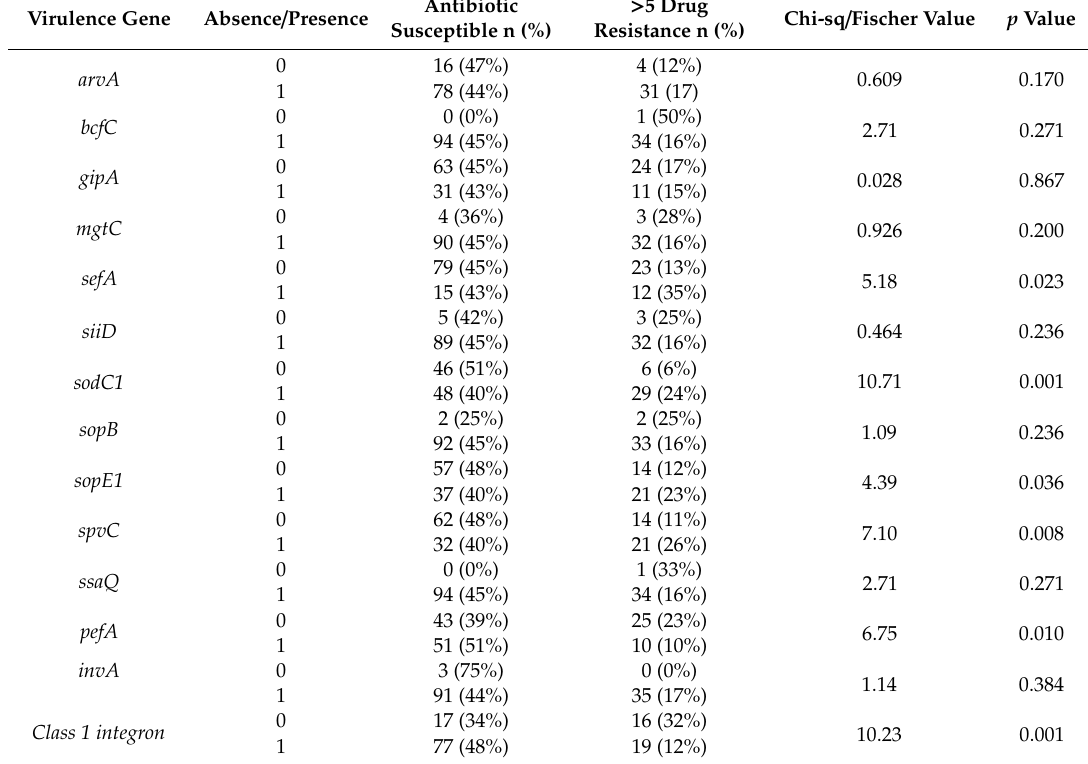
Table 3. Association between > 5 drug resistance and virulence genes in Salmonella isolates ( n =